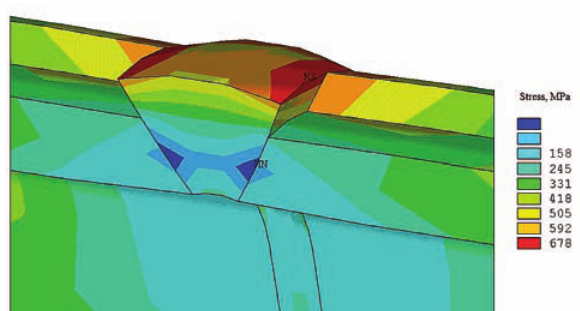
fields with maximized tube 1